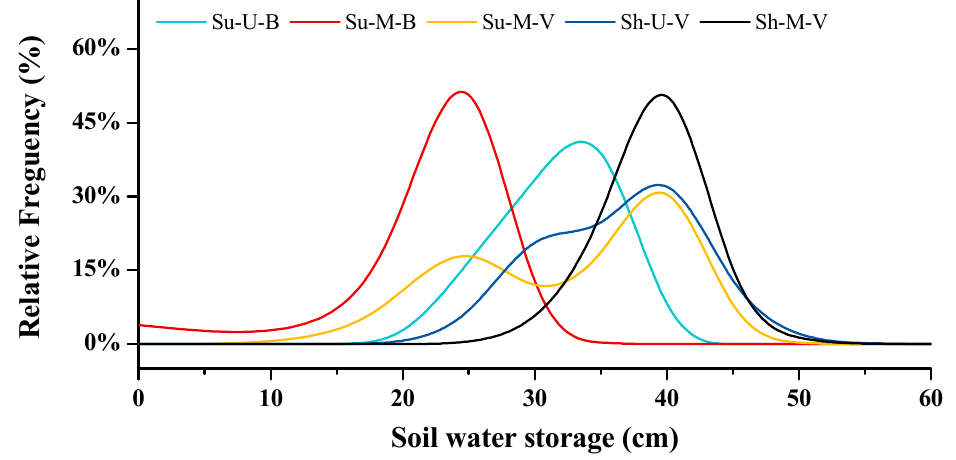
Figure 3. Response of soil water dynamics at five soil depths to five typical rainfall events with the rainfall of 3.5 mm ( a – d ), 13.5 mm ( e – h ), 19 mm ( i – l ), 43.5 mm ( m – p ), and 104 mm ( q – t ) at the five experimental sites, respectively. P is rainfall; I means rainfall intensity; D represents rainfall duration.